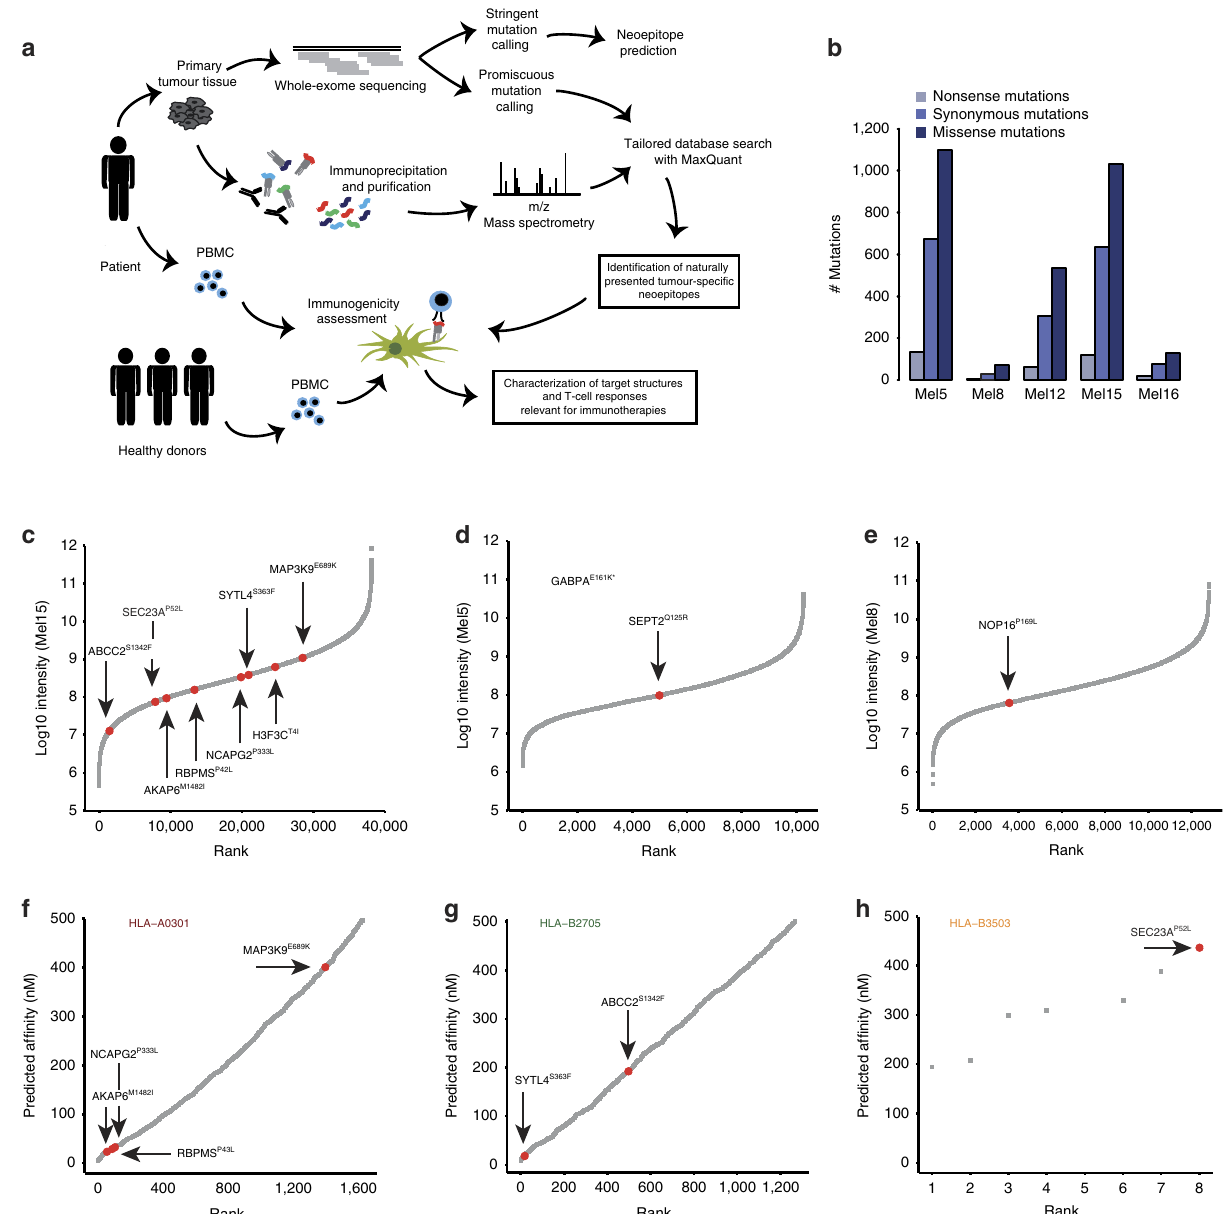
Figure 4 | Identification of mutated peptide ligands by matching exome sequencing and mass spectrometry immunopeptidomics. Overview of the experimental approach. Patient tumour tissue was used for MS analysis and exome sequencing. Mutations were called and matched with MS data. Mutated peptide ligands were then further evaluated for recognition by patient’s autologous and matched allogeneic Tcells ( a ). Overview of the number of non-synonymous and synonymous mutations per patient ( b ). Ranked intensity values of MS data derived from the immunopeptidome of the three patients with identified mutated peptide ligands (Mel15, Mel5 and Mel8). Positions of the mutated peptide ligands are projected on the curve ( c – e ). GABPA E161K was detected at the MSMS level only, therefore no intensity is reported ( d ). Predicted affinity of neoantigen candidates using the 500nM threshold for binders using NetMHC and ranking of neoepitope candidates for Mel15 with respect to HLA-A0301 ( n ¼ 1,632), HLA-B2705 ( n ¼ 1,265) and HLA-B3503 ( n ¼ 8). The mutated peptide ligands detected by MS are not among the top 10 for HLA-A0301 or – B2705 ( f – h